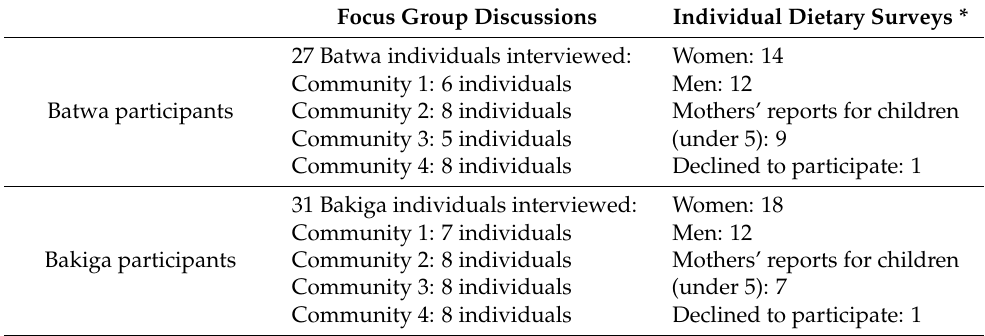
Table 2. Number of participants in the focus group discussions and individual dietary surveys. Focus Group